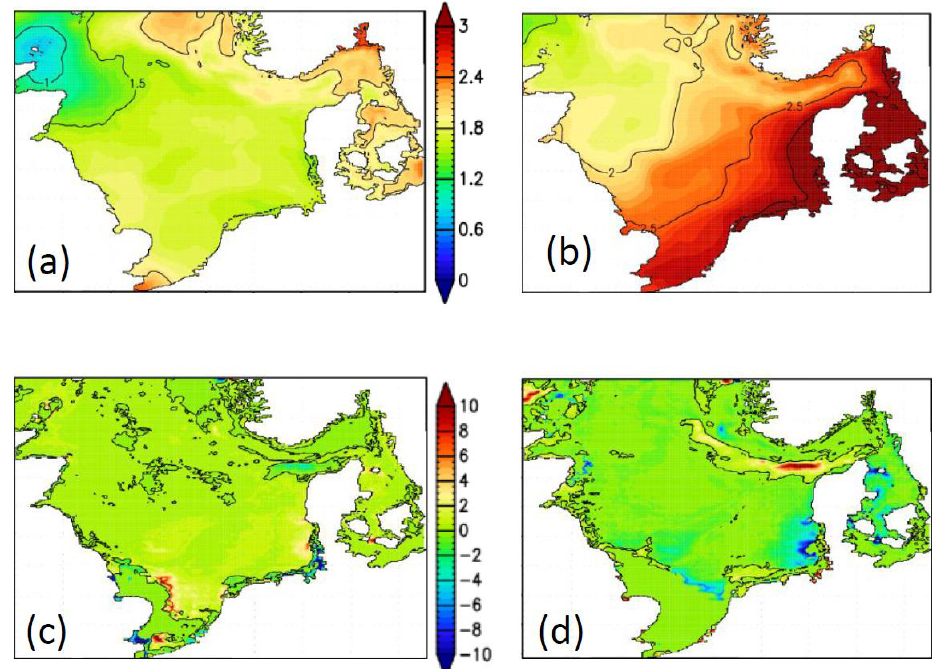
Figure 2. Distributions of 21st century trends. (a) SST in summer (June, July, August); (b) SST in winter (December, January, February), both in ◦ C per 100 years; (c) relative occurrence of erosion in percentage points per 100 years; (d) relative occurrence of deposition in percentage points per 100 years. The upper scale is for (a) and (b) , the lower scale for (c) and (d)